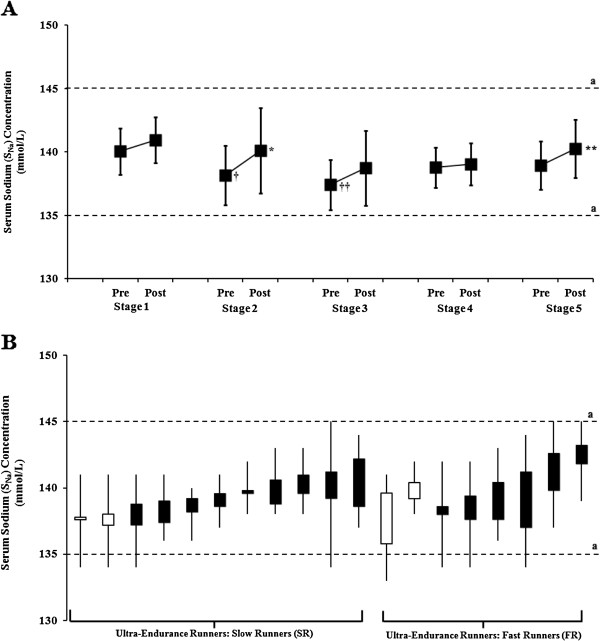
Serum sodium (SNa) responses of UER along MSUM competition. (A) SNa concentration, (B) Individual SNa responses. Mean (SD): UER (■, n = 19), slow runners (SR; MSUM mean speed <8 km/h, n = 11), and fast runners (FR; MSUM mean speed ≥8 km/h, n = 8). a Normal physiological range 135 to 145 mmol/L [32]; hyponatraemia <135 mmol/L [24]. Closed bars represent a pre- to post-stage increase in SNa concentration. Open bars present a pre- to post-stage decrease in SNa concentration. †† p < 0.01 and † p < 0.05 vs. pre-Stage 1; **p < 0.01 and *p < 0.05 vs. pre-stage.